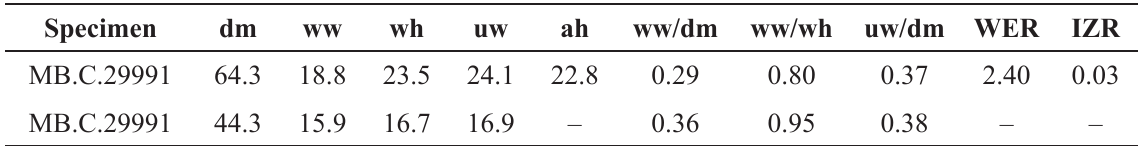
Table 25. Conch dimensions (partly estimated) and ratios of the holotype of Lutites paucis Korn & Hairapetian gen. et sp. nov. from Baghuk